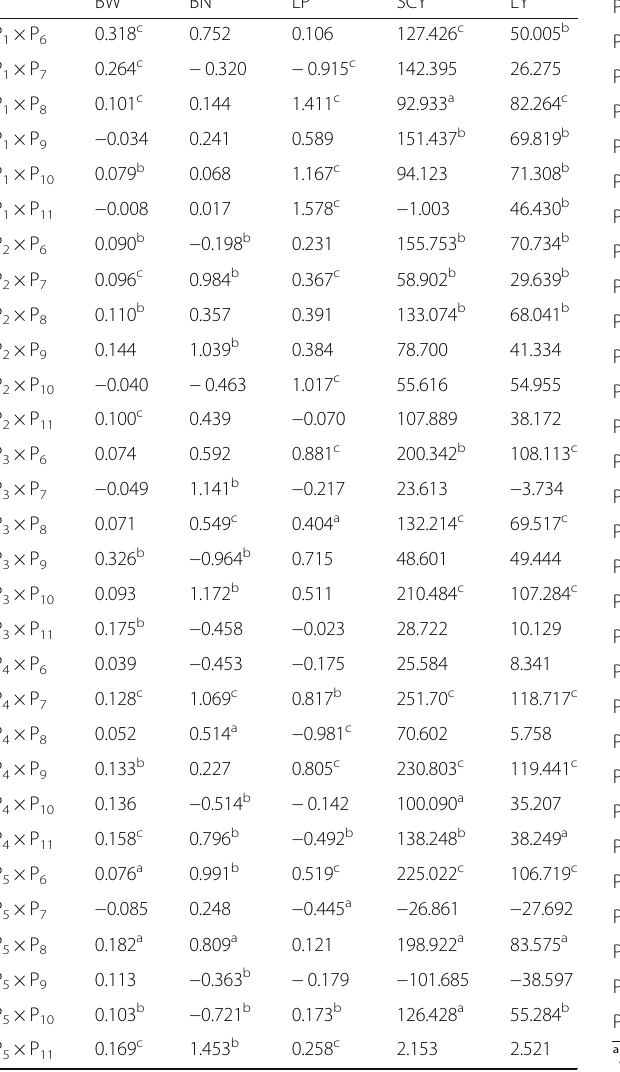
Table 2 Predicted dominant effects for yield and yield component traits